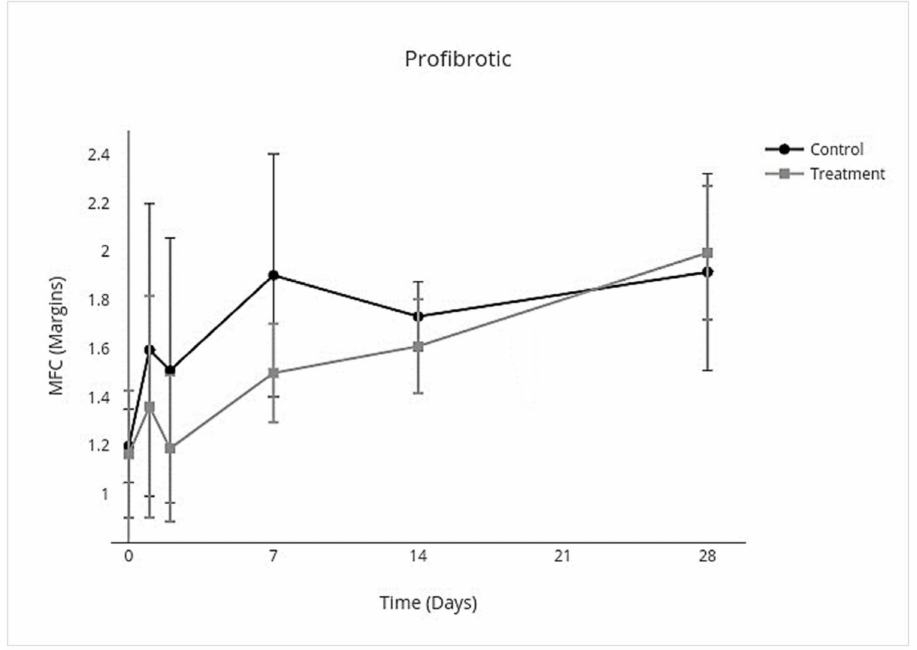
Figure 10. MFC of mRNA expression of profibrotic cytokines over time following IV allo-CB-MSC therapy. In the treatment group, there was an overall treatment effect over all days, characterized by decreased expression of profibrotic cytokines with no significant treatment effect on individual